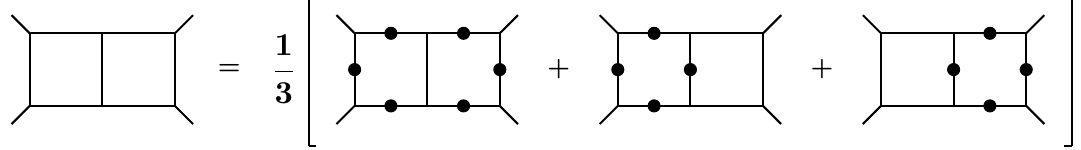
Figure 12 . A double-box can be reconstituted in three distinct ways from ( n +4)-pt tree diagrams. The second way was explicitly considered in section 2.3. The (cid:12)rst way corresponds to nine tree-like diagrams, whereas the second and third correspond to